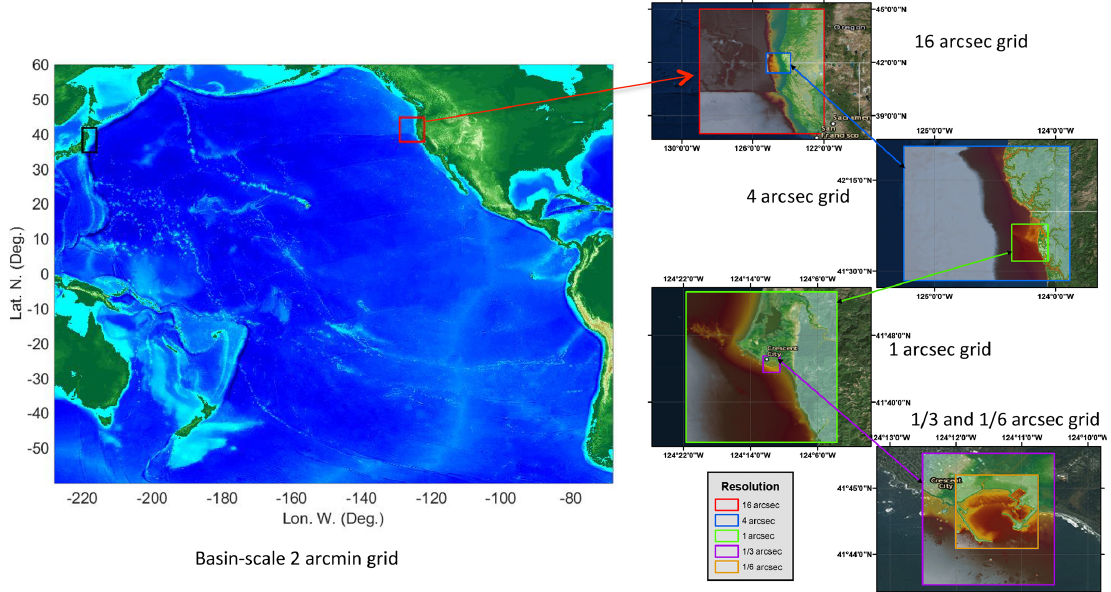
Figure 1. The nested grids in the simulation of the 2011 Tohoku-Oki tsunami impact on Crescent City harbor, Crescent City, California (Tehranirad et al., 2021). The nesting process scales down the grid resolution from 2arcmin in the ocean basin domain to 1 / 6arcsec in the harbor domain. The same simulation was conducted using the present model nesting framework in Sect. 4.4. Courtesy of Google Maps © 2021 Google, ©